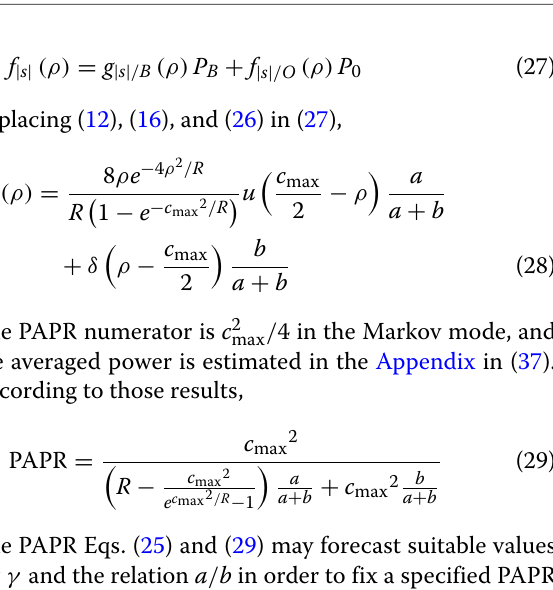
Fig. 5 Markov simulation elements. a AM-AM Cree PA-measured and PM-identified model. b 5 MHz Markov-LINC ACPR Performance in terms of transition probabilities